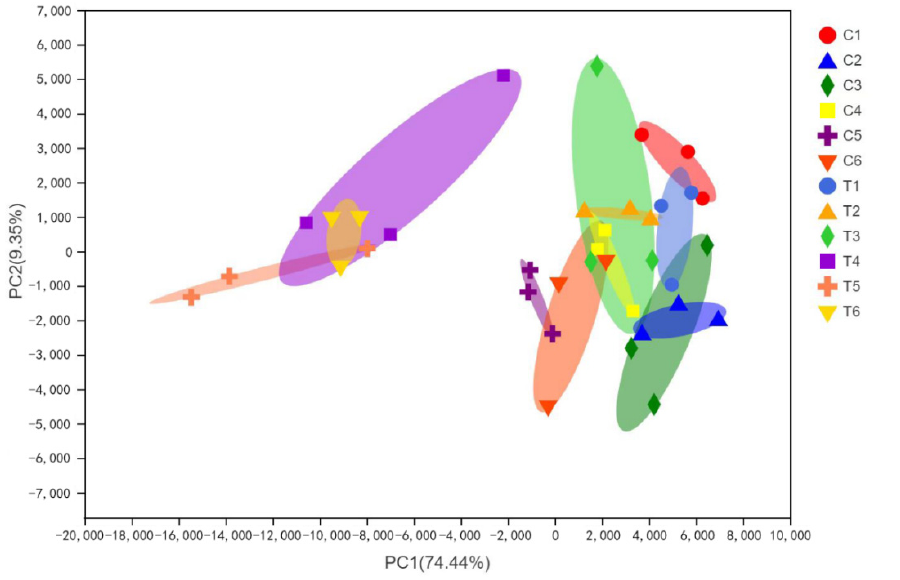
Figure 2. Principal component analysis (PCA) of bacterial communities in two groups during ensiling (n = 3): C, WPCS without inoculant; T, WPCS treated with B. Subtilis inoculant. The numbers 1, 2, 3, 4, 5, and 6 represent the day 1, 3, 5, 10, 30, and 45 of ensilage time.